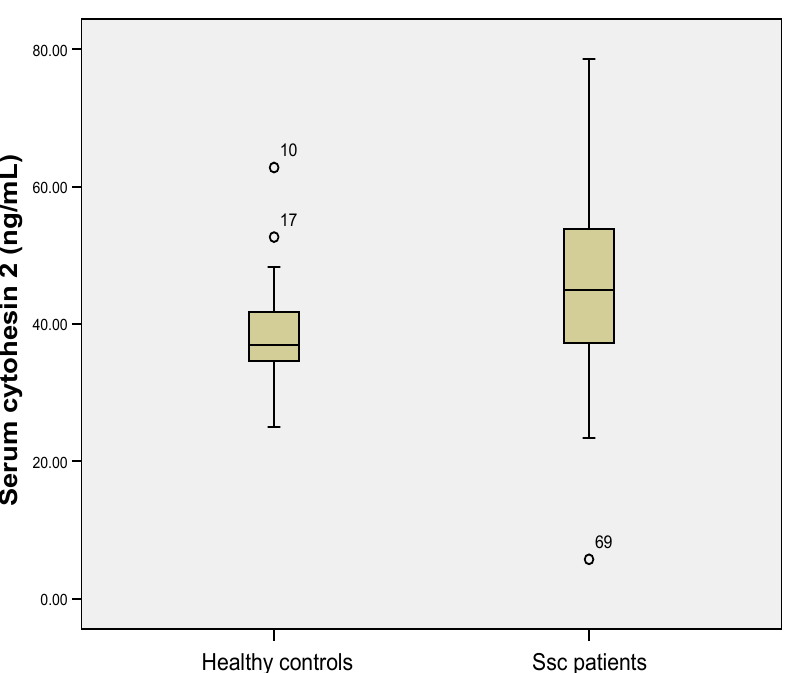
Figure 4. Serum cytohesin 2 levels were higher in Ssc (systemic sclerosis) patients compared to healthy controls ( p < 0.001, Mann Whitney U test). The circle and numbers in figure represent the patient ID in the database that are considered outliers by the statistical software used.